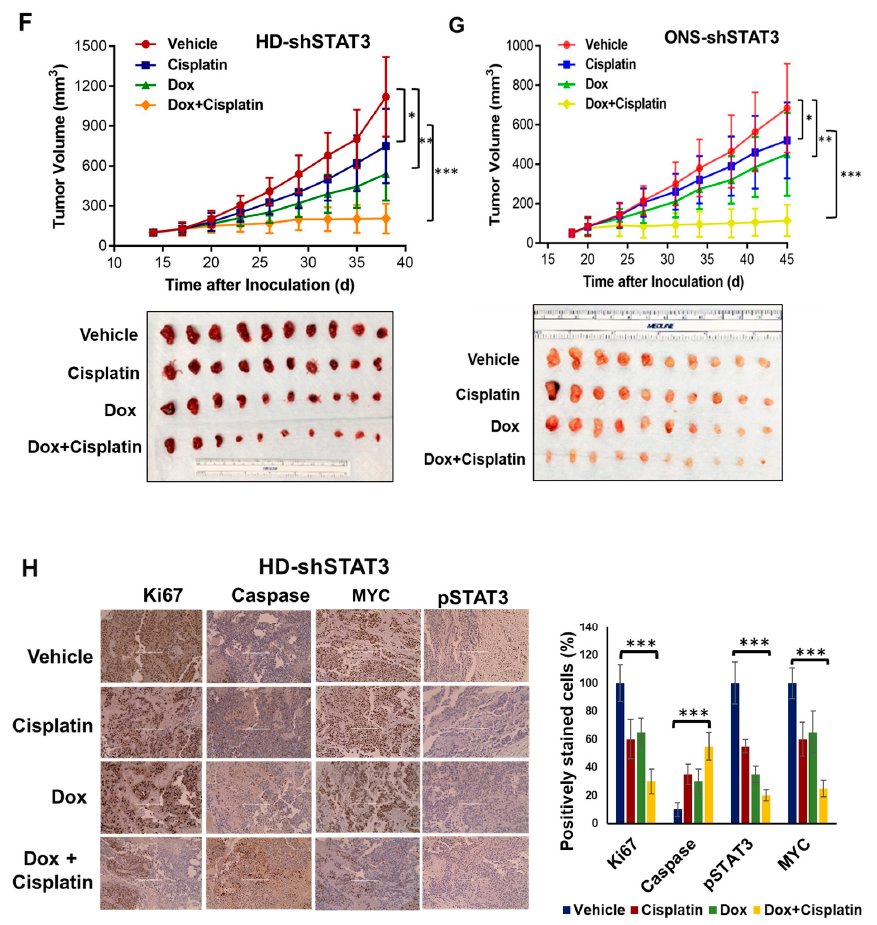
Figure 5. STAT3 KD confers chemosensitivity to MB cells and tumors. ( A ) HD-shSTAT3 and ( B ) ONS-shSTAT3 cells were treated either with increasing concentrations of cisplatin alone or in combination with 0.5 µ g/mL Dox for 48 h and cell viability was measured by MTT assay; * p < 0.05, ** p < 0.01. ( C ) HD-shSTAT3 cells were treated with either Dox or cisplatin alone or in combination or left untreated for 12 days. Colonies formed were fixed, stained (left) and counted from triplicate wells and are shown in a bar diagram (right); ** p < 0.01 ( D ) STAT3 target gene expressions were analyzed in HD-shSTAT3 and ( E ) ONS-shSTAT3 cells by qPCR, either in the presence of Dox or cisplatin alone, or in combination; * p < 0.05. ( F ) HD-shSTAT3 and ( G ) ONS-shSTAT3 cells (0.5 × 10 6 ) were subcutaneously implanted in 5- to 6-week-old athymic nude mice. Mice were given water supplemented either with Dox (2 mg/mL in drinking water) or saline (vehicle), which was continued throughout the experiment. Cisplatin (2 mg/kg) was injected twice a week intraperitoneally or in combination with Dox. The tumor size in treated groups (Dox, cisplatin and Dox + cisplatin) was compared with that of vehicle. Tumor volume was measured at indicated days and a tumor growth curve was plotted (top). Resected xenograft tumors (bottom) after completion of treatment were shown. Plotted values and error bars represent mean ± SEM. ( H ) Representative IHC images (20 × ) of the xenograft sections of Ki-67, caspase-3, MYC and pSTAT3 are shown. The percentage of Ki-67-, caspase-3-, MYC- and pSTAT3-positive cells derived from histology scores were quantified in the three tumor sections of each treatment group; *** p < 0.001